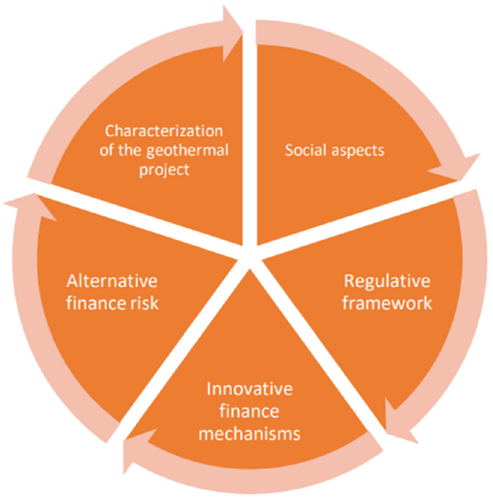
Figure 13. Elements in a community-based geothermal project to be built in Europe.